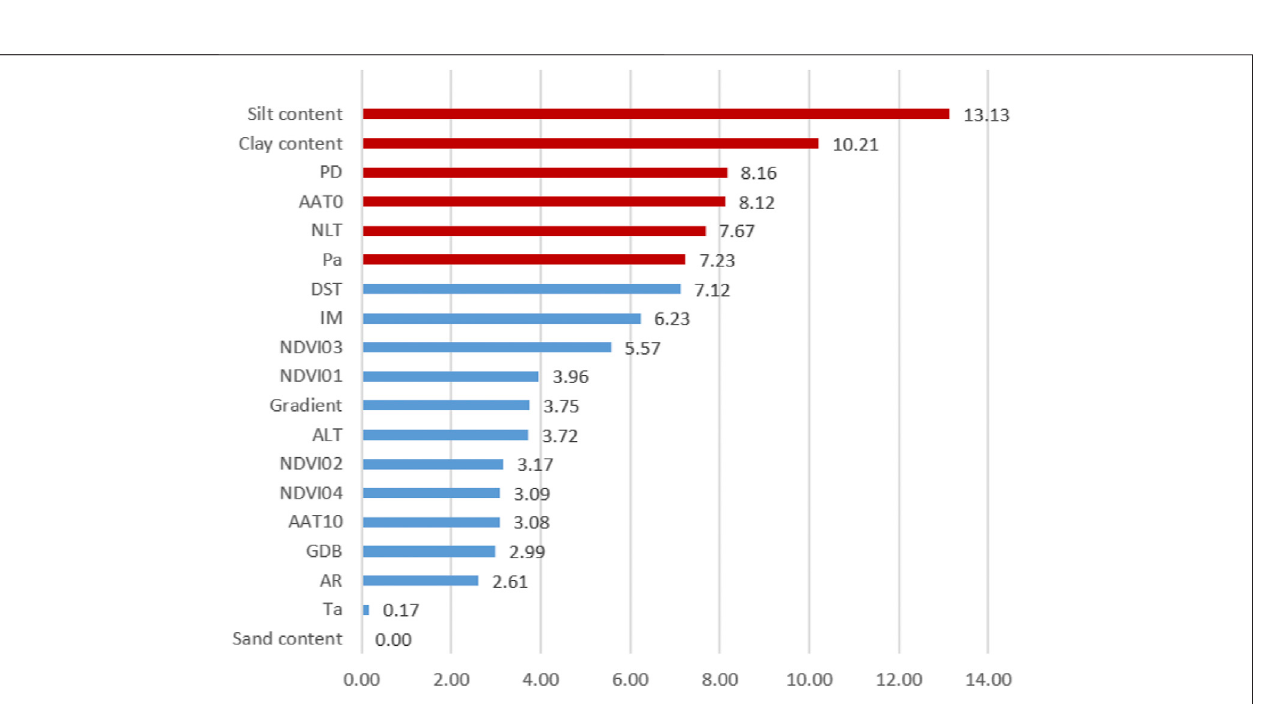
FIGURE 4 | Contributors to potential Oncomelania hupensis